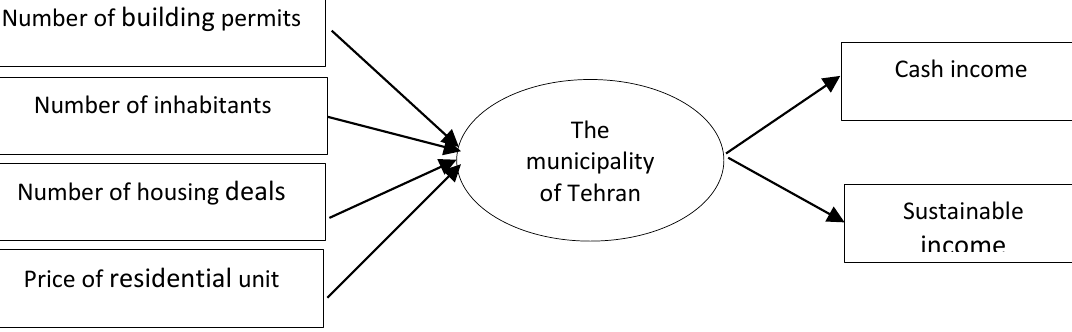
Fig. 2. Components of proposed DEA model Table 1: Output and input data set of The Municipality of Tehran districts